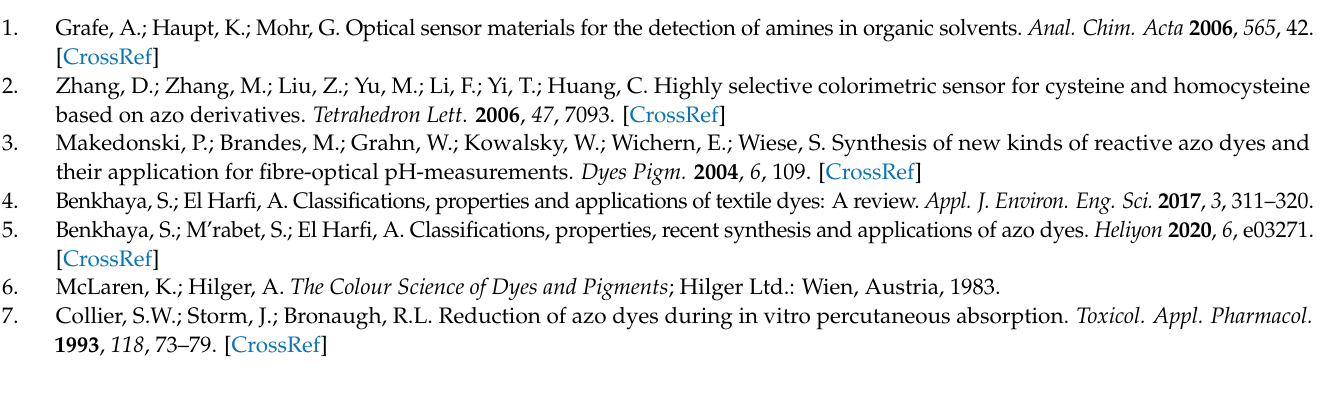
and ligand; Figure S3. UV–Vis (zero) spectrum of complex equilibrium studies of metals (Cu(II), Co(II), Pb(II), Ni(II)) with azo-azomethine derivatives: N-AMP-2 (C = 4.88 × 10 − 5 mol L − 1) at approximately equal concentrations of metals and ligand; Figure S4. UV–Vis (zero) spectrum of complex equilibrium studies of metals (Cu(II), Co(II), Pb(II), Ni(II)) with azo-azomethine deriva- tives: N-AMP-3 (C = 5.21 × 10 − 5 mol L − 1) at approximately equal concentrations of metals and ligand; Figure S5. Fluorescence spectra of the N-AMPs (from left to right) and their metal com- plexes with Cu(II), Ni(II), Co(II), Pb(II) (from top to bottom) with molar ratios of metal: ligand = 1:1 (the red lines) and 1:2 (the blue lines); the concentrations of the central ions: 3.238 × 10 − 5(Cu(II)), 8.52 × 10 − 5(Ni(II)), 8.89 × 10 − 5(Pb(II)) and 3.431 × 10 − 5(Co(II)) mol L − 1 at 0.25 mL from each ion; Figure S6. UV–Vis absorption spectra of solutions containing Cu (II) and ligand: N-AMP1(L1) with different molar fractions of the two binding agents; Figure S7. UV–Vis absorption spectra of solutions containing Cu (II) and ligand: N-AMP3(L3) with different molar fractions of the two binding agents; Figure S8. UV–Vis absorption spectra of solutions containing Ni (II) and ligand: N-AMP2(L2) with different molar fractions of the two binding agents; Figure S9. Plots of pH vs. VNaOH obtained from potentiometric data at determination of the stability constants of metal–L1 complexes. The molar ratio in the solution containing metal is: metal ion: ligand = 1:2; Table S2. Values of constant formation and their logarithmic (log β ) of obtained complexes of azo-azomethine derivatives with metal ions at molar ratio metal: ligand = 1:2; Figure S10. DP anodic voltammetry at Pt working electrode in 0.1 mol L − 1 acetate buffer as a supporting electrolyte and equal concentrations of the ligands: 5.71 × 10 − 6 mol L − 1(L1), 5.69 × 10 − 6 mol L − 1(L2), 6.57 × 10 − 6 mol L − 1(L3); Figure S11. Differential pulse voltamperograms (cathodic) of azo-azomethine metal complex compounds in ammonium (pH 10.35, 0.1 mol L − 1) buffer solutions at HMDE working electrode and Ag/AgCl, KCl (3 mol L − 1) as reference electrode; Table S3. Values of potentials (Ep, (V)) and current intensities (Ip, (A)) of electroactive components (metal–ligand and unbound forms: metal and ligand) in ammonium (pH 10.35, 0.1 mol L − 1 ) and borate (pH 9.18, 0.1 mol L − 1 ) buffer solutions used as electrolyte medium at mercury working electrode in DPP